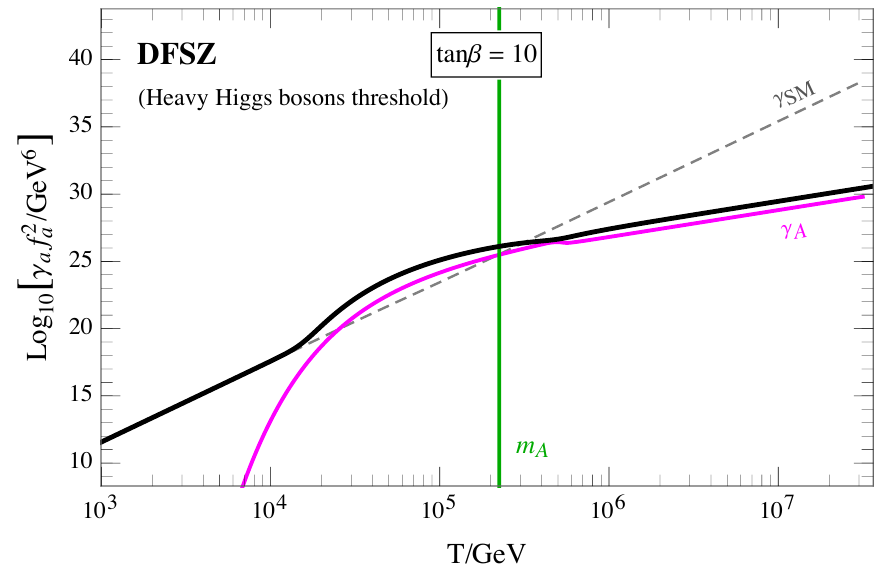
Figure 5 . DFSZ axion production rate across the heavy Higgs bosons thresholds. We set tan β = 10 √ and 2 B = 10 5 GeV ’ m . The solid black line denotes the total rate. The solid magenta line A ( γ ) is the partial rate from scatterings of heavy Higgses. The dashed gray line ( γ A to the rate due to only SM particle scattering